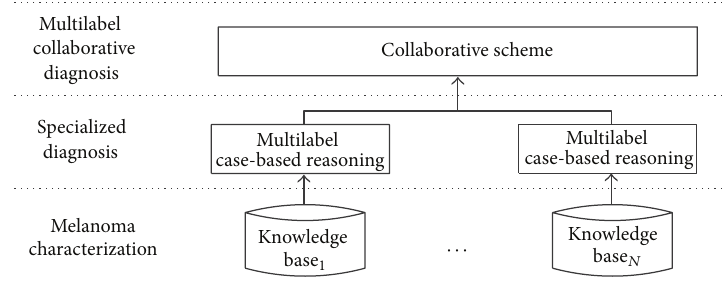
Figure 1: Melanoma diagnosis architecture based on collaborative multilabel